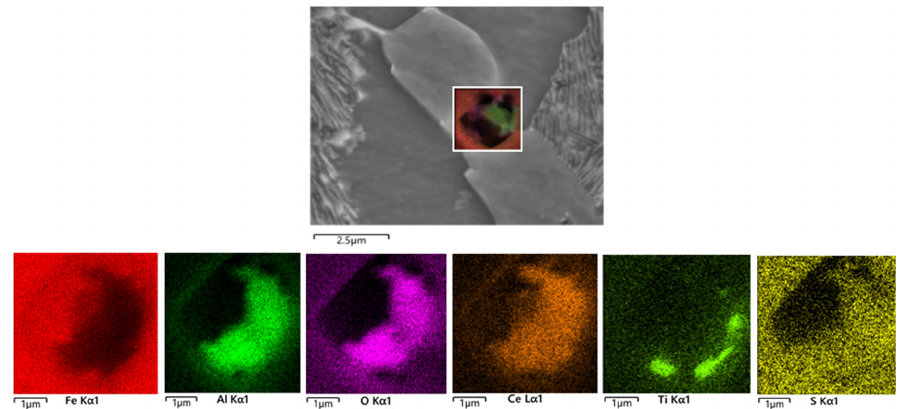
2 O 3 -CaS inclusions in 1# sample.